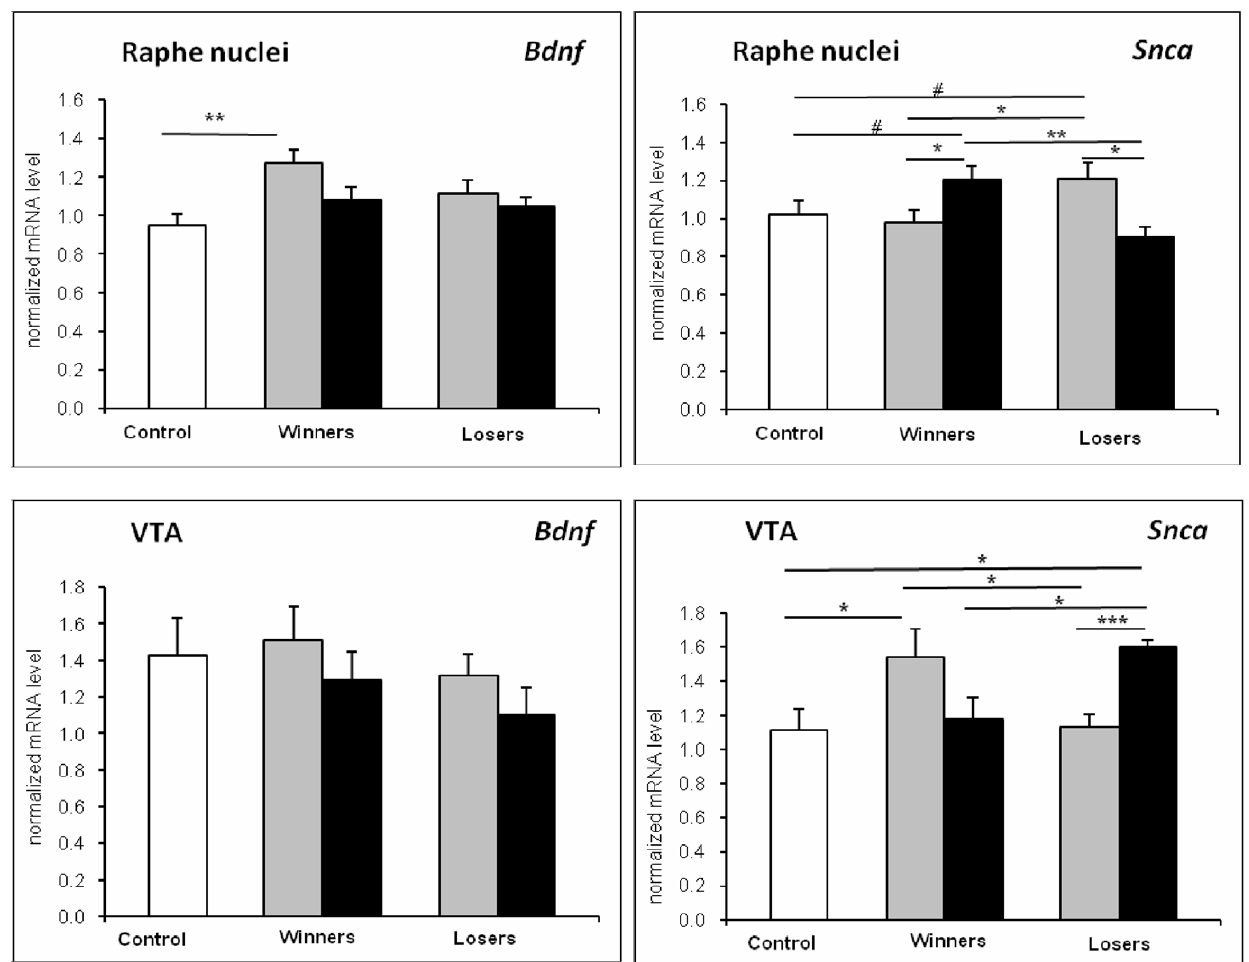
Figure 1. The normalized Snca and Bdnf mRNA levels in the VTA and raphe nuclei of midbrain of the controls (white columns), 20- time winners and 20-time losers (grey columns) and no-fighting winners and no-fighting losers (black columns). * p , 0.05; ** p , 0.01; *** p , 0.001; # - 0.05 , p , 0.1 comparisons between respective groups.